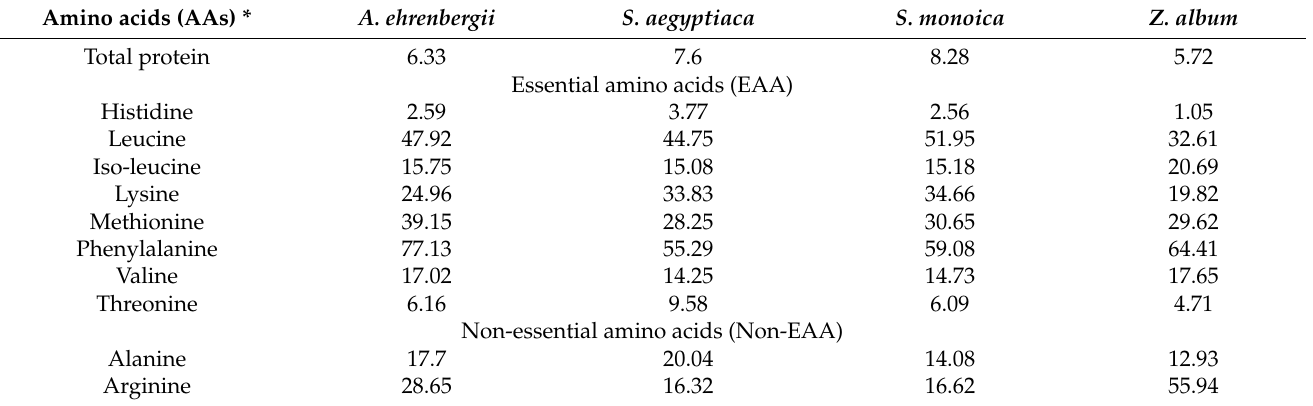
Table 3. Protein content (%) and amino acid compositions ( µ g/g DW) of the Red Sea halophytes. Amino acids (AAs)